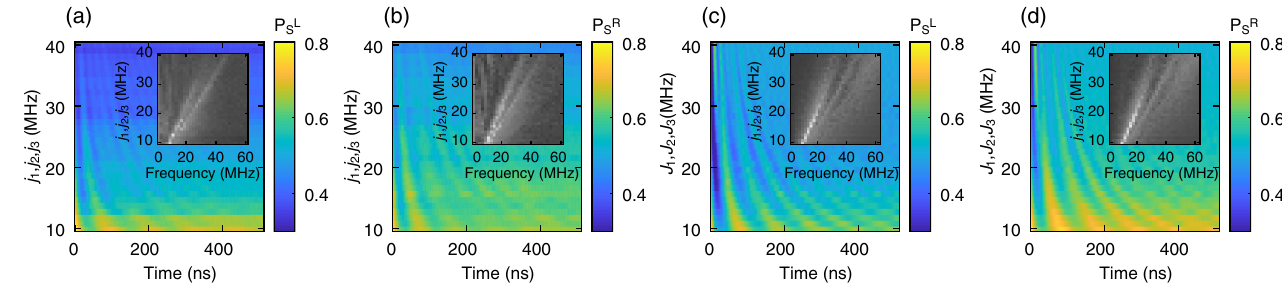
FIG. 5. Four-spin exchange oscillations. (a) Experimental data measured on the left side. Inset: FFT of the data. (b) Experimental data measured on the right side. Inset: FFT of the data. (c) Simulated four-qubit exchange oscillation data on the left side. Inset: FFT of the simulation. (d) Simulated four-qubit exchange oscillation data on the right side. Inset: FFT of the